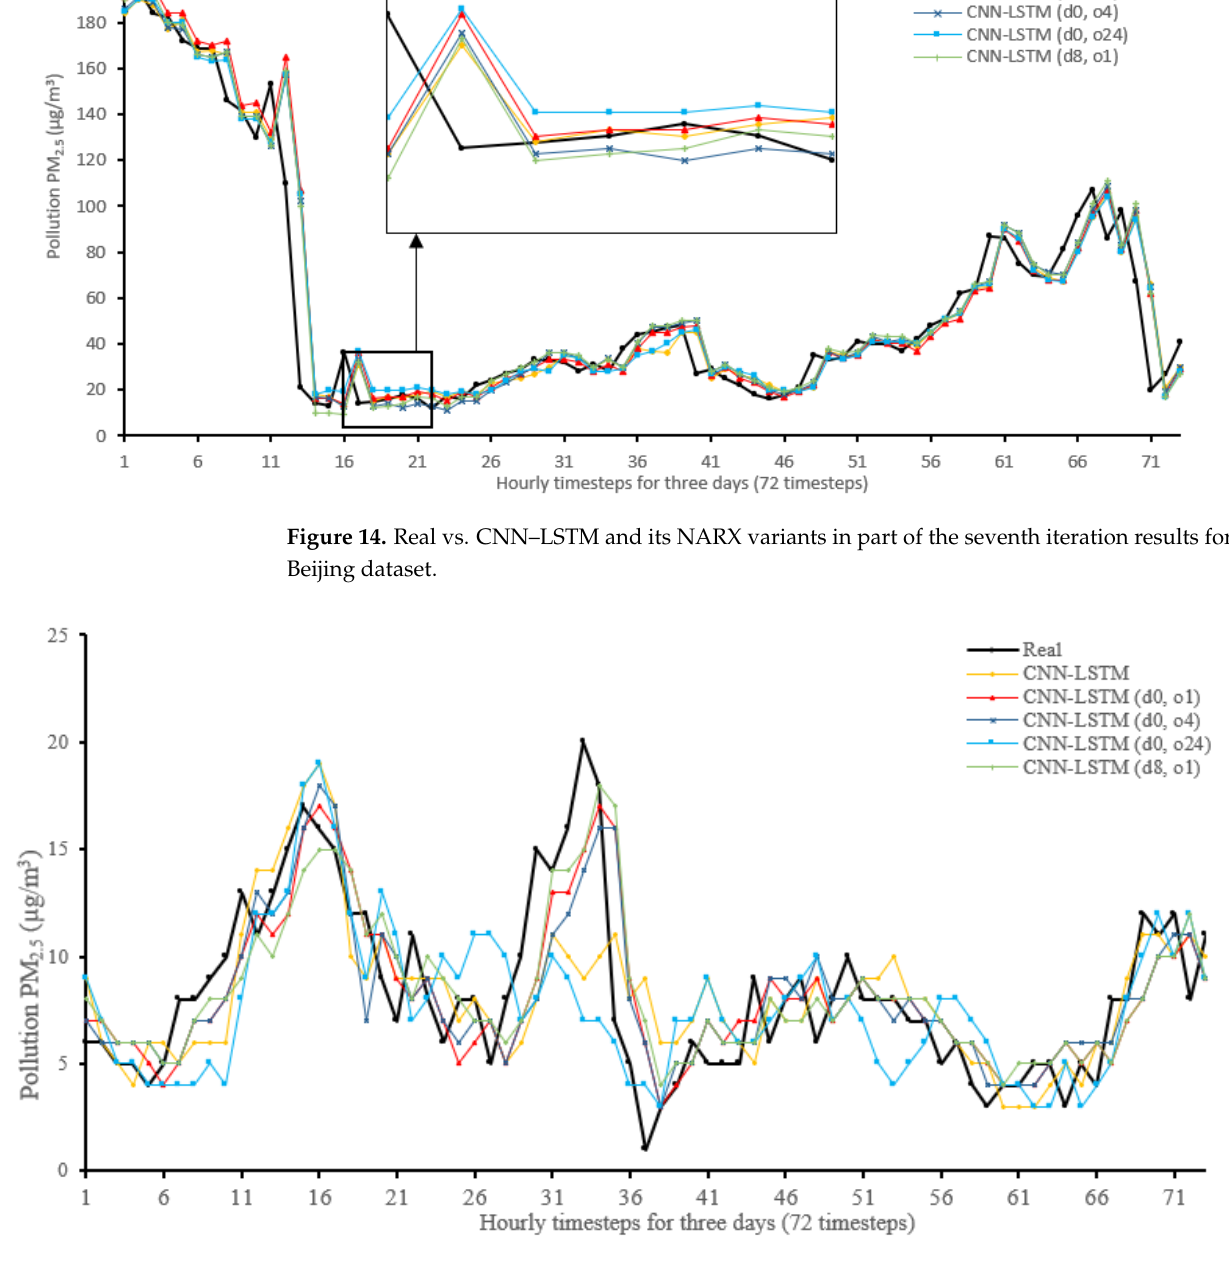
Figure 15. Real vs. CNN–LSTM and its NARX variants in part of the seventh iteration results for the Manchester dataset.